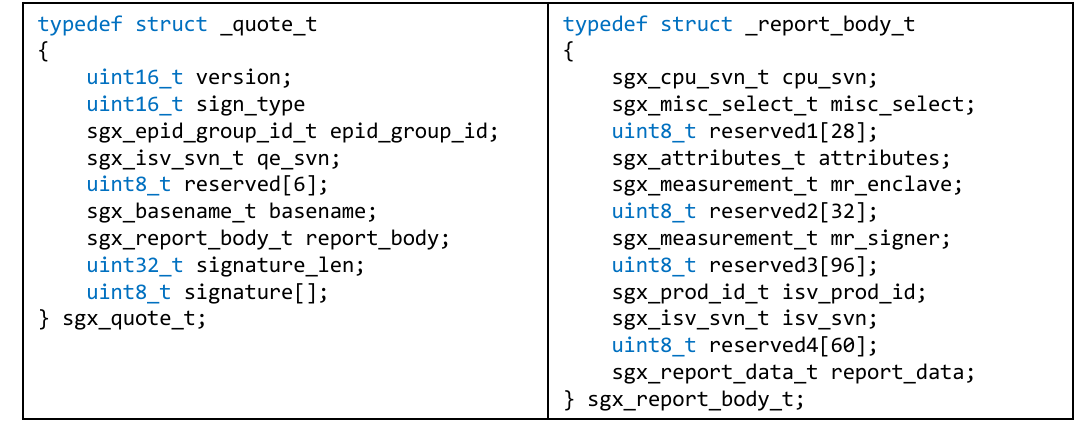
Figure 2. Data Structure for Remote Attestation in Intel